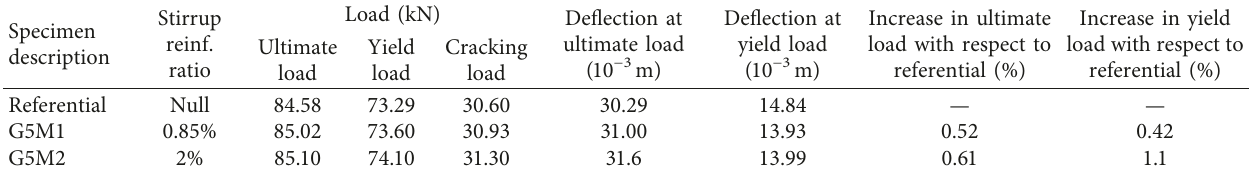
Table 19: Load-deflection response of specimens with different joint stirrup ratios.